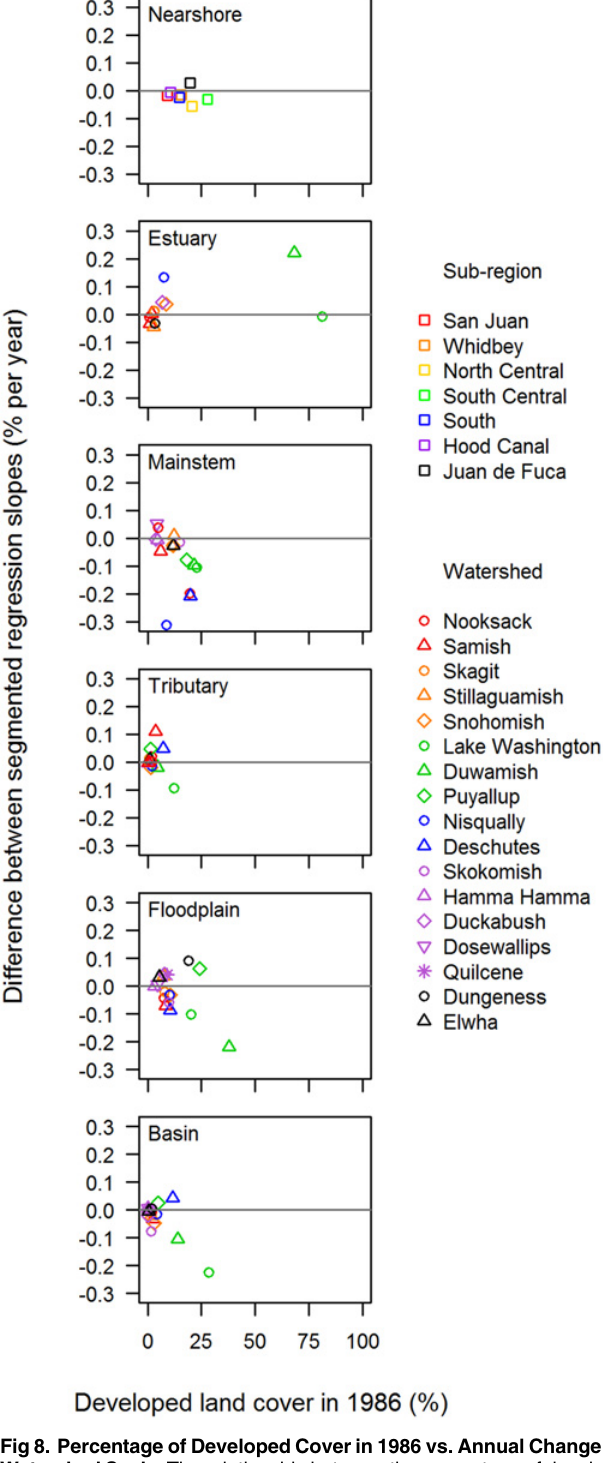
Fig 8. Percentage of Developed Cover in 1986 vs. Annual Change in Developed Land Cover ( b 2 – b 1 ): Watershed Scale. The relationship between the percentage of developed land cover in 1986 and the difference in the annual rate of change in the percentage of developed cover before and after the breakpoint ( b 2 – b 1 in Eq 2), for each of six habitat areas. Positive values on the y -axis indicate that the slope of the right- hand segment (latter part of the time series) exceeds the slope of the left-hand segment (earlier part of the time series); negative values indicate the